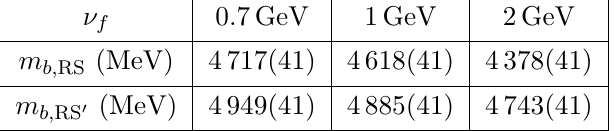
Table 1 . RS and RS’ bottom quark masses for di(cid:11)erent values of (cid:23) f . last column of table 1 and the values in eqs. (2.2) and (2.4) is completely marginal. In